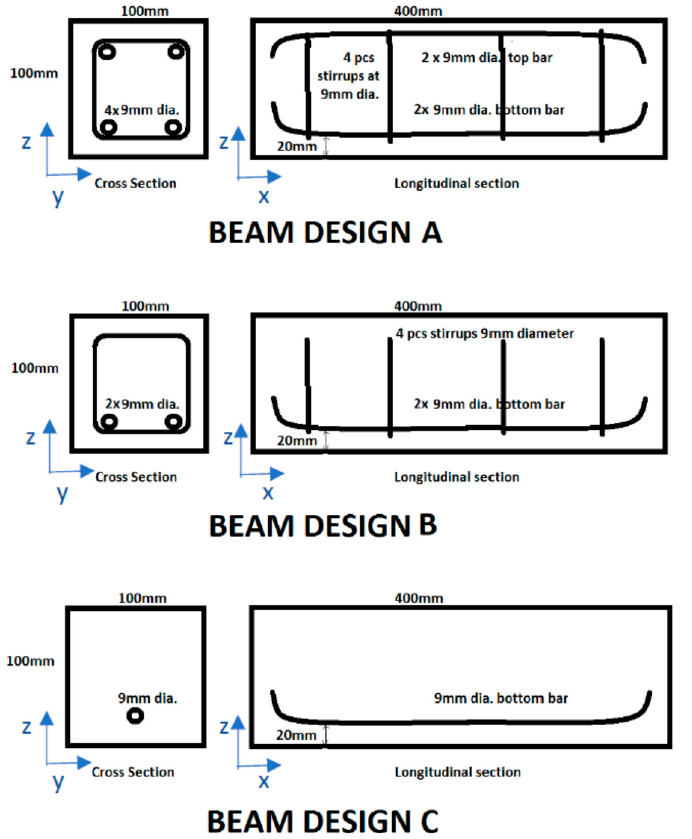
Figure 3. Reinforcements of the three beams.